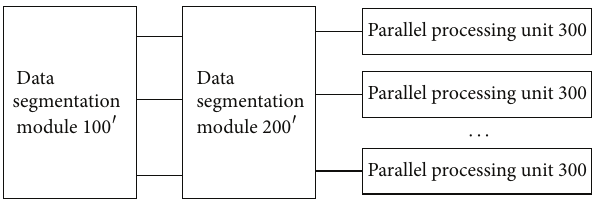
Figure 5: Model of adjacent zero communication parallel cloud computing